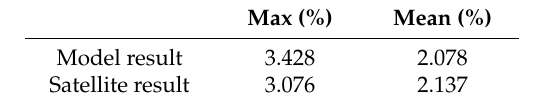
Table 6. Maximum and mean whitecap coverage over the eastern part (83 ◦ E–135 ◦ E, 44 ◦ S–56 ◦ S).